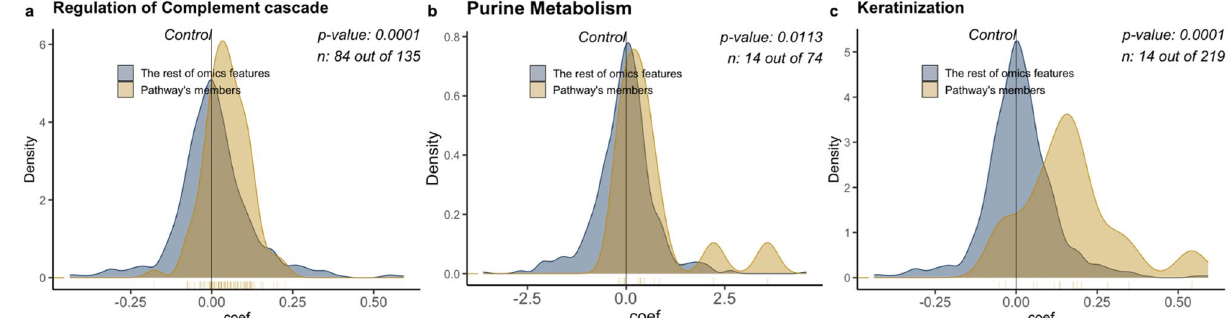
Figure 5. Enrichment pathway between severe group and healthy group. Pathway enrichment analysis was performed for metabolite profiles and protein profiles separately. Each metabolite (protein) assigned a rank based on coefficient from testing severe group vs. healthy group using generalized linear models. We applied our omePath tool with a Wilcoxon signed rank test and HMDB database 120 as the reference for metabolite pathways and the Reactome pathway database 121 with Physical Entity (PE) class for Uniprot to all levels of the pathway hierarchy mapping file. ( a ) Regulation of Complement cascade pathway using protein data was significantly enriched in the COVID-19 positive patients, with non-severe health outcome compared to the healthy group. ( b ) Purine Metabolism pathway using metabolite data was significantly enriched in COVID-19 positive patients with the severe health outcome compared to the healthy group. ( c ) Keratinization pathway using protein data was significantly enriched in COVID-19 positive patients with the non-sever health outcome compared to the healthy